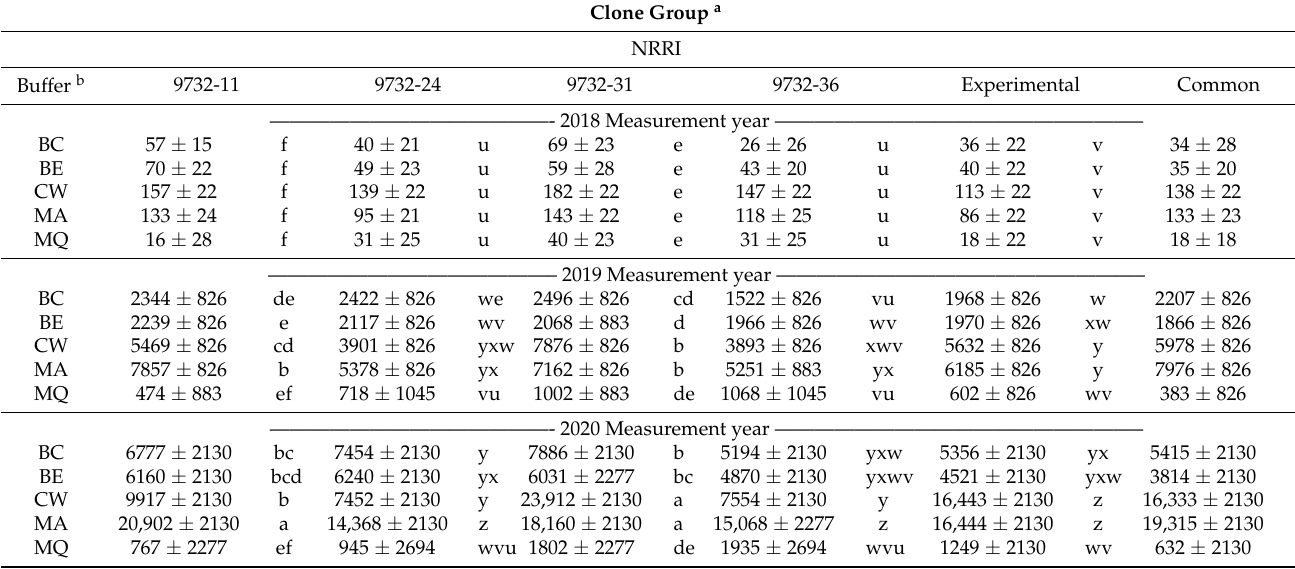
Table 5. Volume (cm 3 ) ( ± one standard error) of three poplar clone groups tested in five phytoremediation buffer systems (i.e., phyto buffers) established in 2018 (i.e., the 2018 Buffer Group) in the Lake Superior watershed of the Upper Peninsula of Michigan, USA and the Lake Michigan watershed of eastern Wisconsin, USA. Trees were measured following the 2018, 2019, and 2020 growing seasons. Volume values with different letters within a clone column across measurement years are different at p <